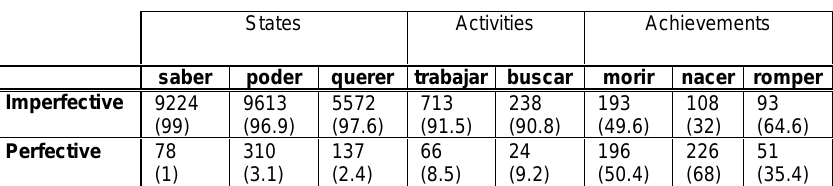
Table 3: Distribution of verb forms (raw numbers and percentages) according to imperfective (present, imperfect) and perfective (preterit) verb forms.